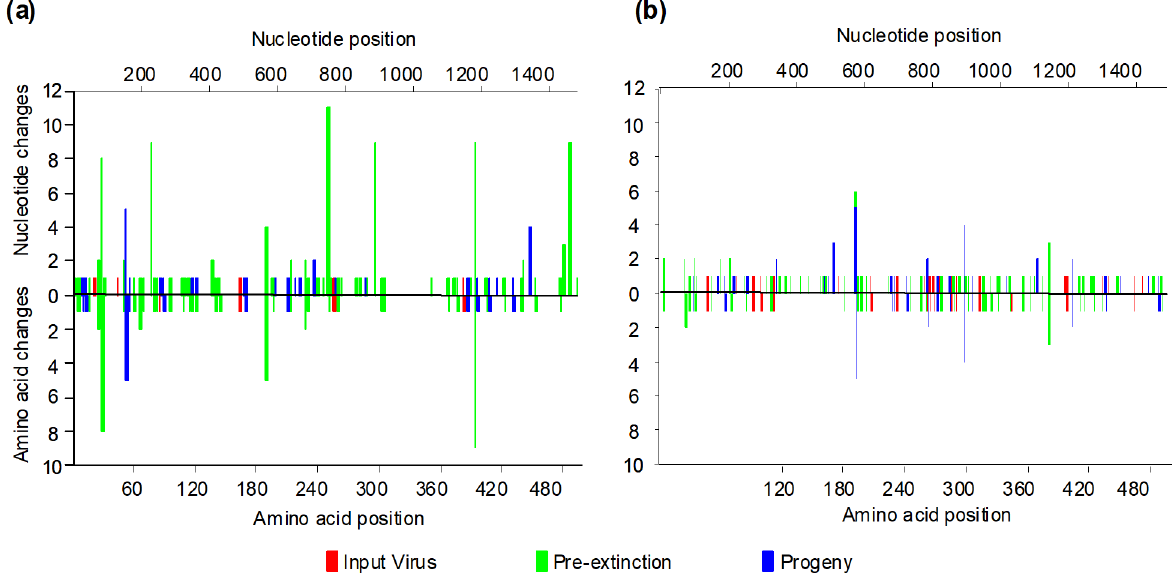
Fig 5. Distribution of variable sites across the envelope protein genes of (a) wild type and (b) infectious clone derived DENV1 populations prior to 5FU treatment (red), after two passages in 5FU (green; P2, pre-extinction populations, Fig 2) and after recovery from 5FU treatment (blue; progeny [Prog] population, Fig